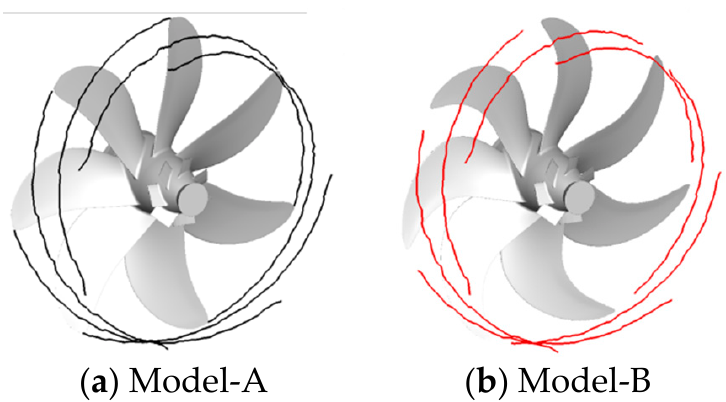
Figure 10. A variation of λ 2 along the circular line in Figure 9b .